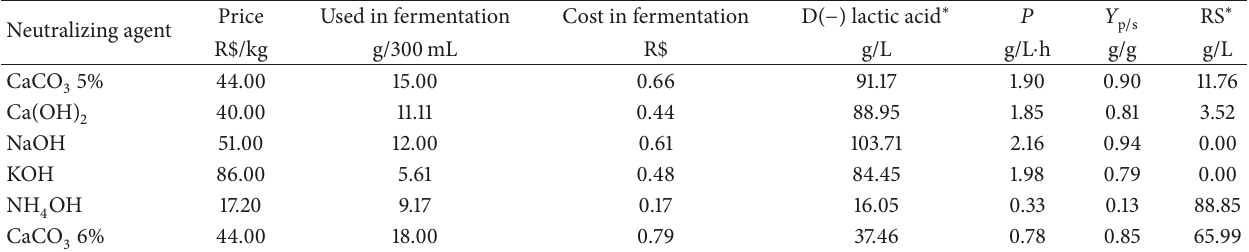
Table 4: Comparison of D-lactic acid fermentation by S. nakayamae using different neutralizing agents. Neutralizing